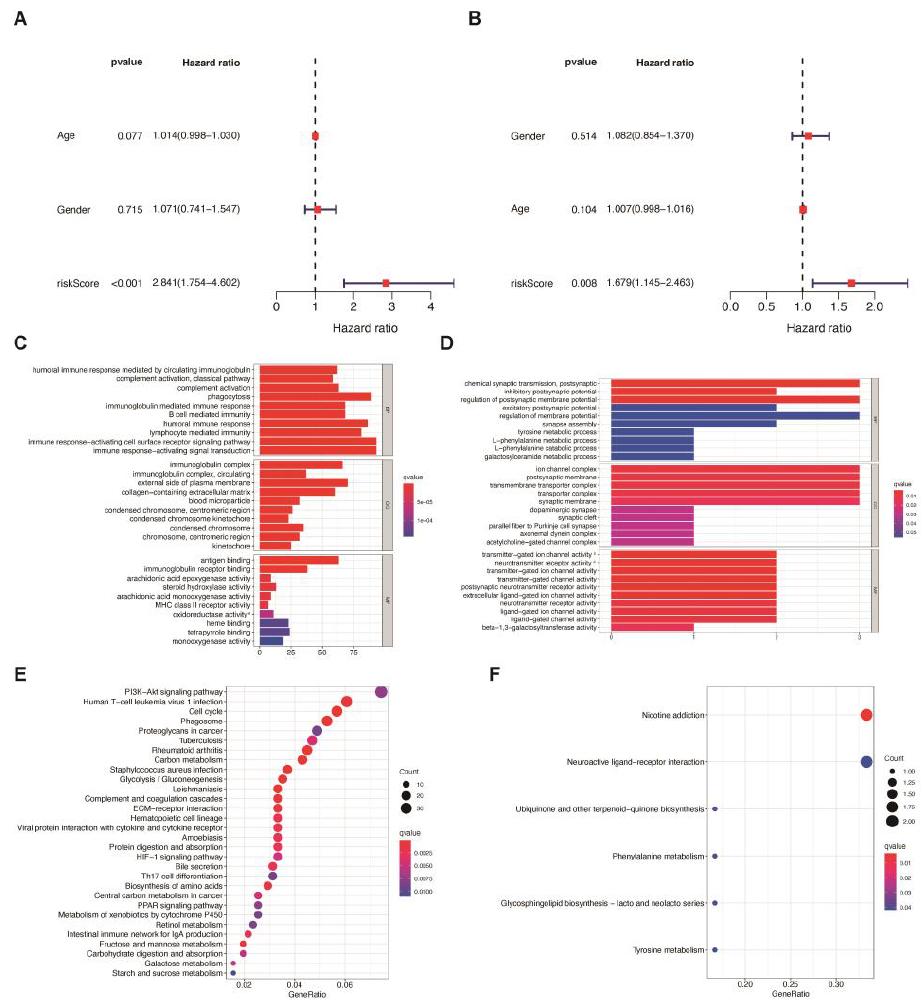
Figure 4. Multivariate Cox regression analysis for risk score classification and gene set enrichment analysis for DEGs between high-risk and low-risk groups. Red square: hazard ratio; blue line: 95% CIs. ( A , B ) Multivariate Cox regression analysis and forest plot of the survival in TCGA ( A ) and CGGA ( B ). ( C , D ) GO analysis among the DEGs between high-risk and low-risk groups in TCGA ( C ) and CGGA ( D ). ( E , F ). KEGG analysis among the DEGs between high-risk and low-risk groups in TCGA ( E ) and CGGA ( F